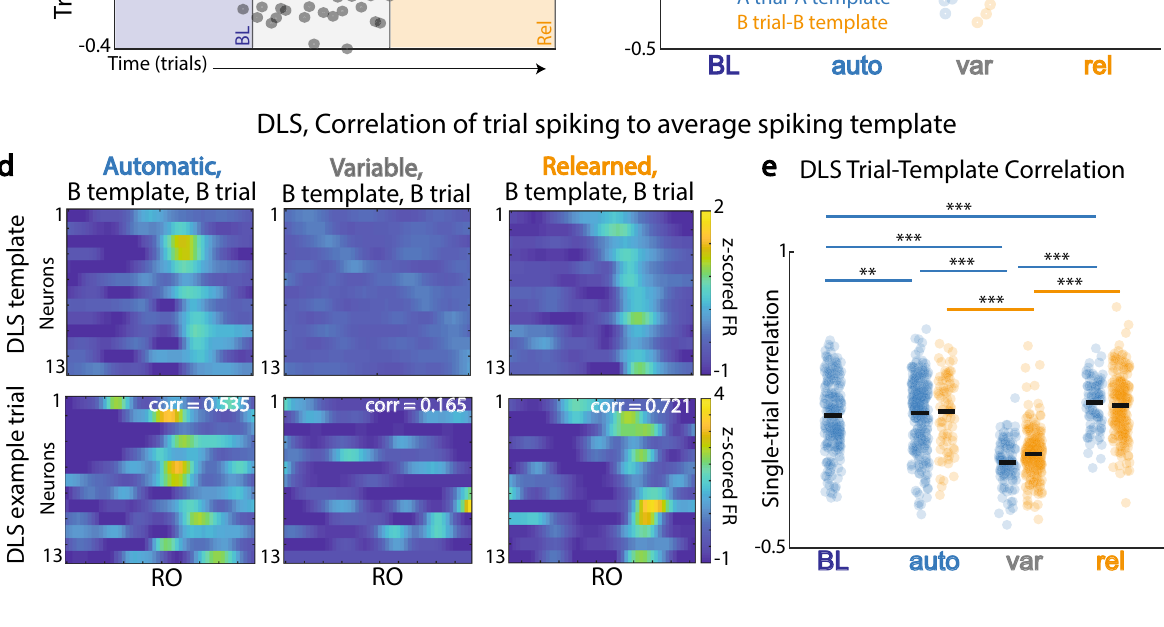
NATURE COMMUNICATIONS| (2022) 13:2450